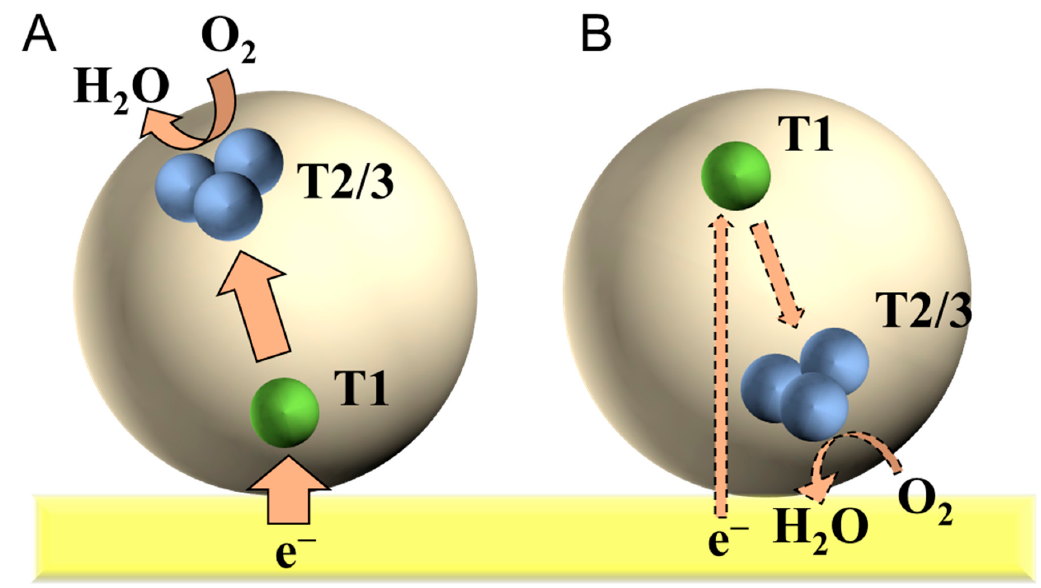
Figure 6. Schematic illustrations for the adsorbed bilirubin oxidas (BOD) at flat electrode in (A) effective and (B) invalid orientations for the DET-type bioelectrocatalysis.